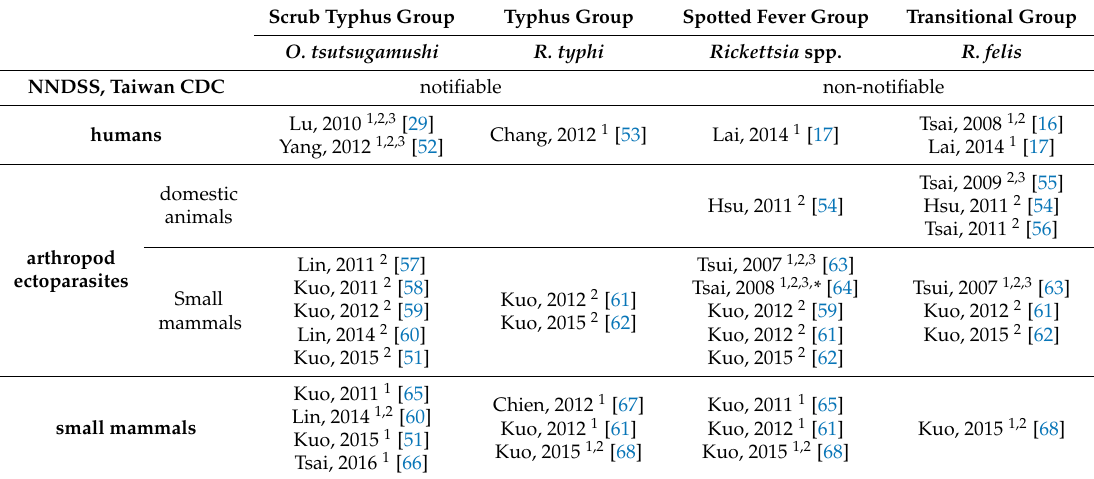
Table 1. Clinical and ecological evidence of re-emerging and emerging human VBR in